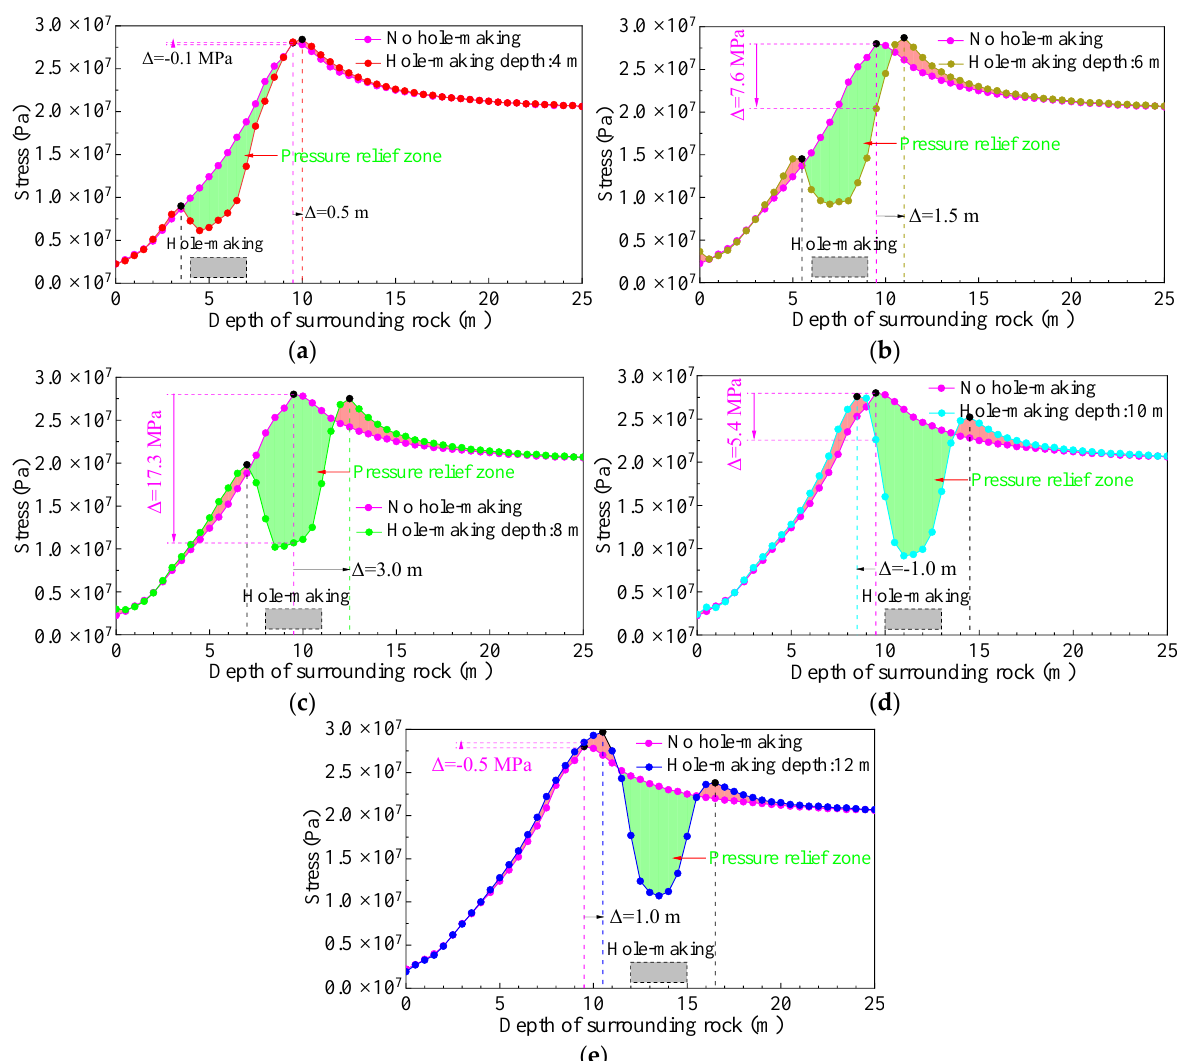
Figure 9. Layout scheme under different hole-making depths and distribution nephogram of verti- cal stress.